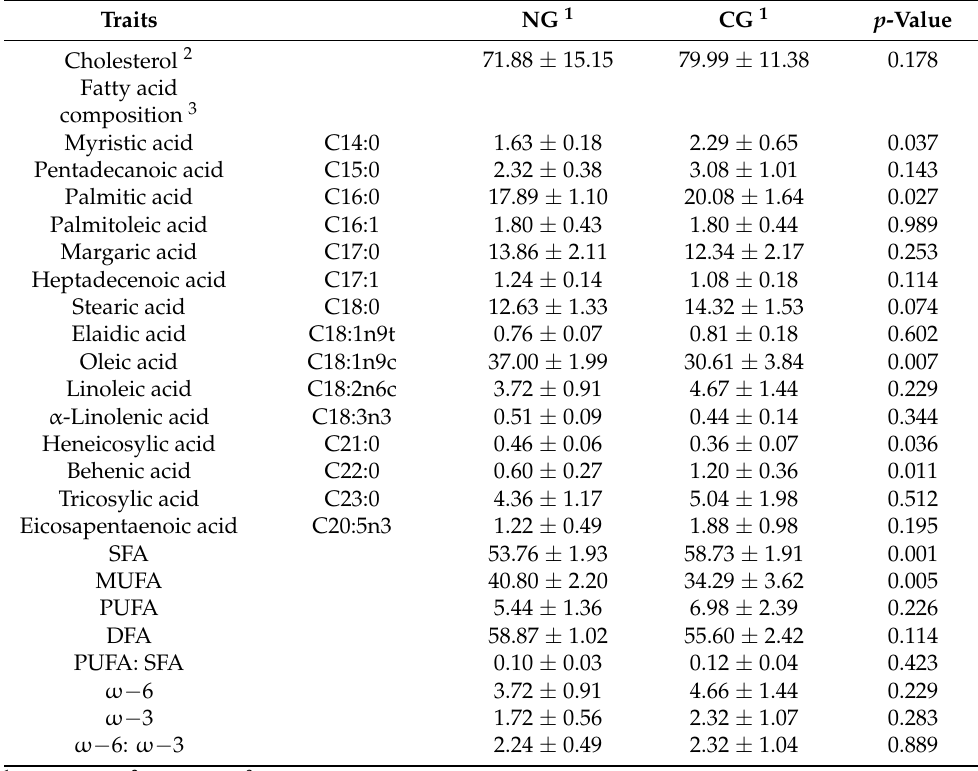
Table 5. Cholesterol content and fatty acid composition in Longissimus thoracis m. of Southern Thai native goats (NG) and Three-way crossbred goats (CG).